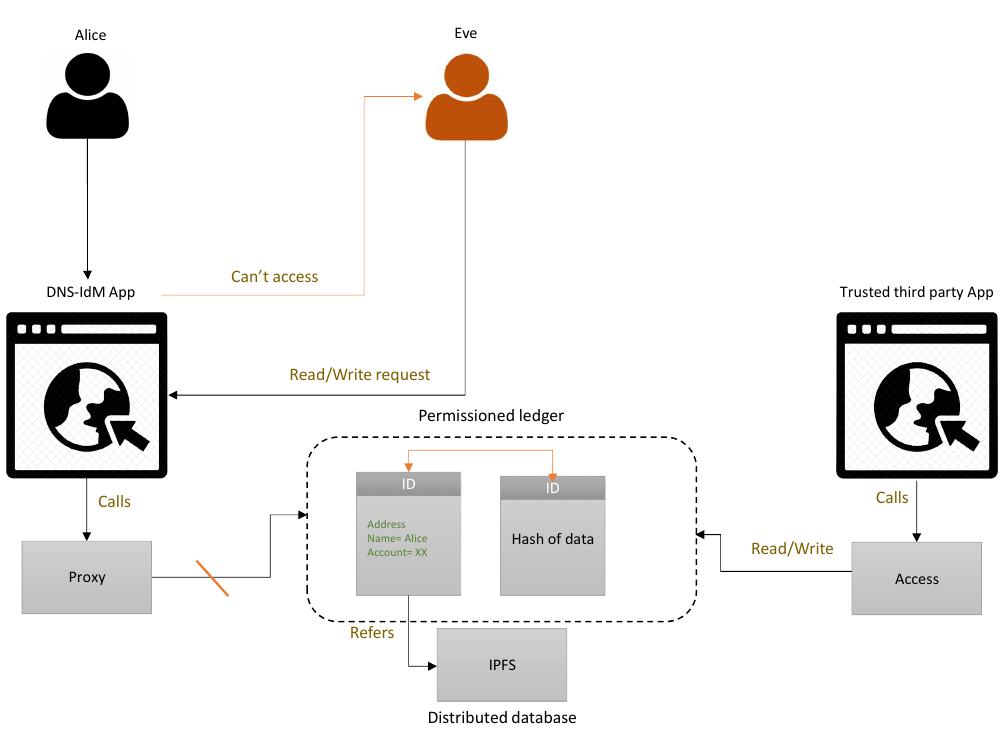
Figure 7. Providing protected and private ownership to